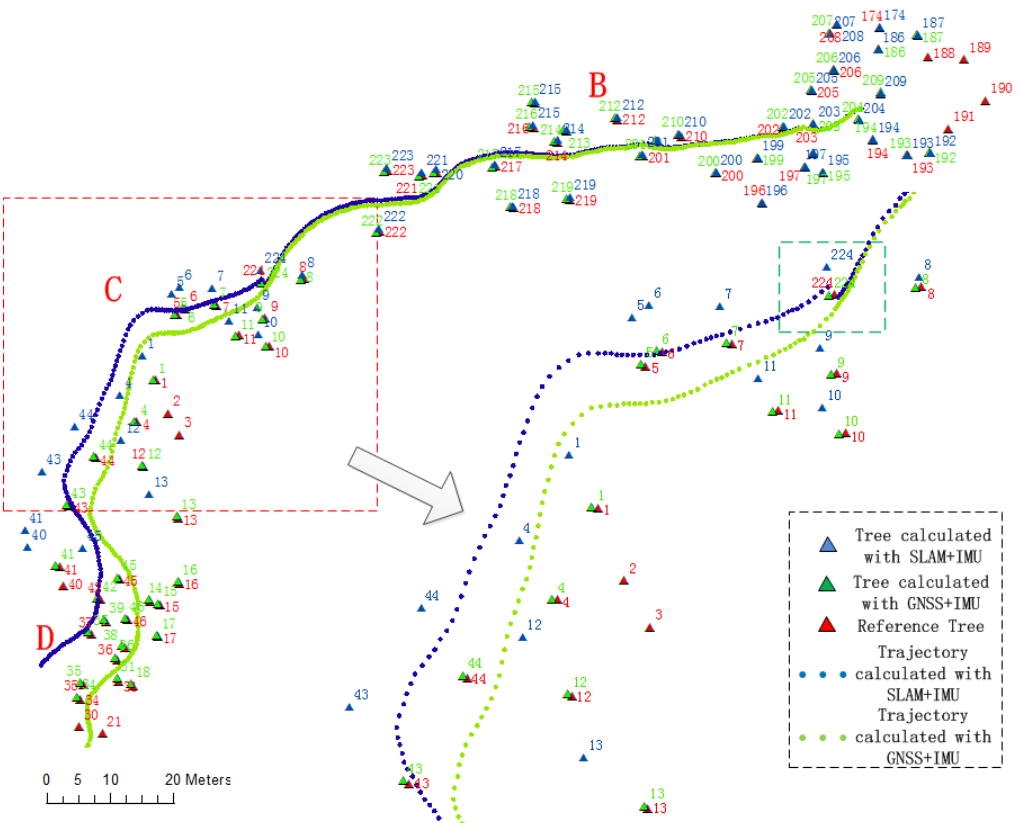
Figure 9. Trajectory and stem position comparison between the GNSS + IMU and SLAM + IMU methods in an open forest environment. Green dots are the trajectory of GNSS + IMU; blue dots are the trajectory of SLAM + IMU; red triangles are the reference tree position; green triangles are the tree positions calculated with the GNSS + IMU method; blue triangles are the tree positions calculated with the SLAM + IMU method. Lack of trees to the left of the trajectory is obvious.